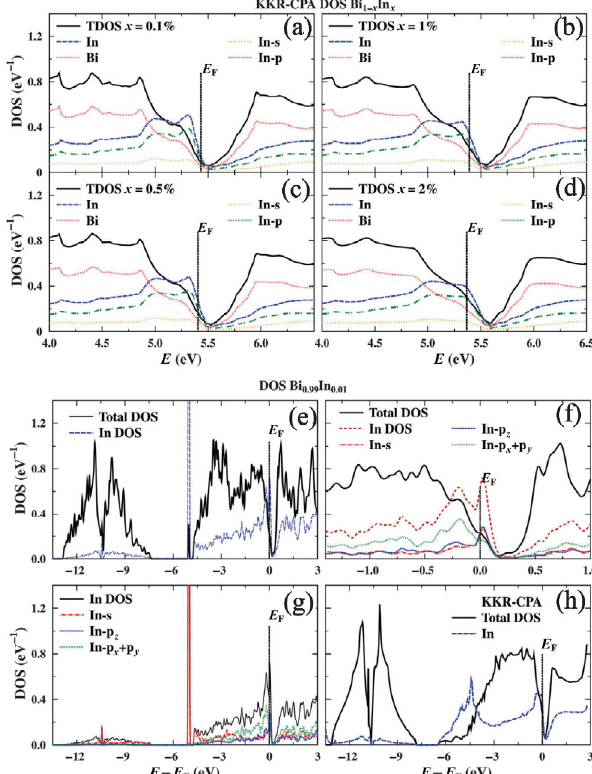
Figure 3 The DOS evolution for Bi 1– x In x obtained from the KKR-CPA calculation. The Bi and In individual atomic contributions are related. (a) x = 0.1% (b) x = 0.5% (c) x = 1% (d) x = 2%. (e)–(g) DOS from FP-LAPW supercell calculated result obtained for Bi 0.99 In 0.01 . (h) KKR-CPA result. The overall DOS in (a)–(c) is averaged over the number of